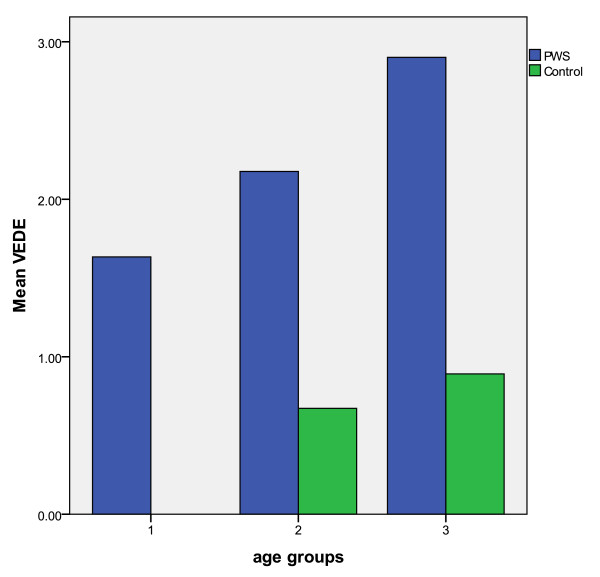
Tooth wear presented as mean VEDE for individuals in PWS- and control-group divided in three equally large age groups. Age groups (mean age, range years): 1; 9.8 (6.1-13.6) (n = 32), 2; 20.2 (13.7-25.4) (n = 34), 3; 31.5 (25.5-42.5) (n = 32).